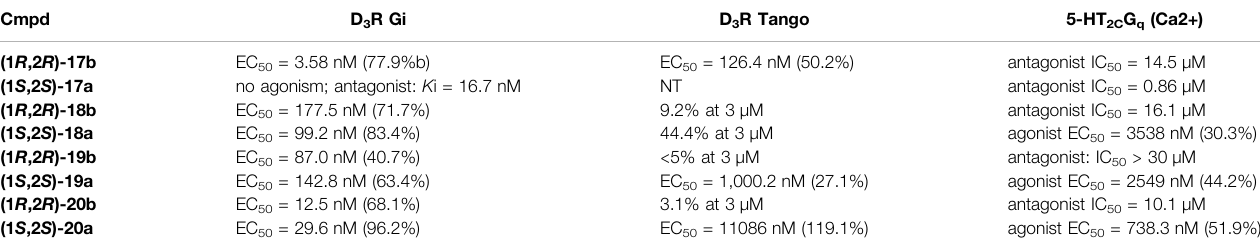
TABLE 4 | Functional Data of compounds at D 3 R and 5-HT 2C (All compounds were tested as HCl salts. For agonist activity, Emax values are shown in brackets. NT, not tested.).